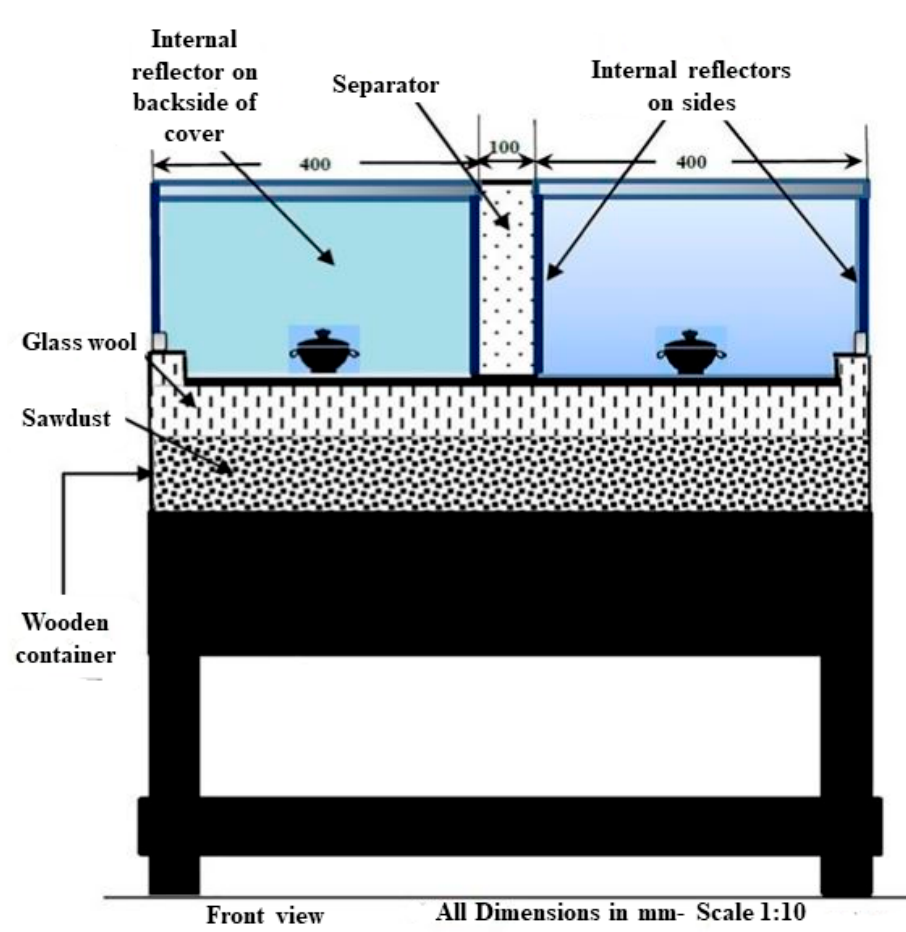
Figure 14. Schematic diagram of Quonset solar cooker (QSC). Reprinted with permission from Ref. [42], 2020, Elsevier.